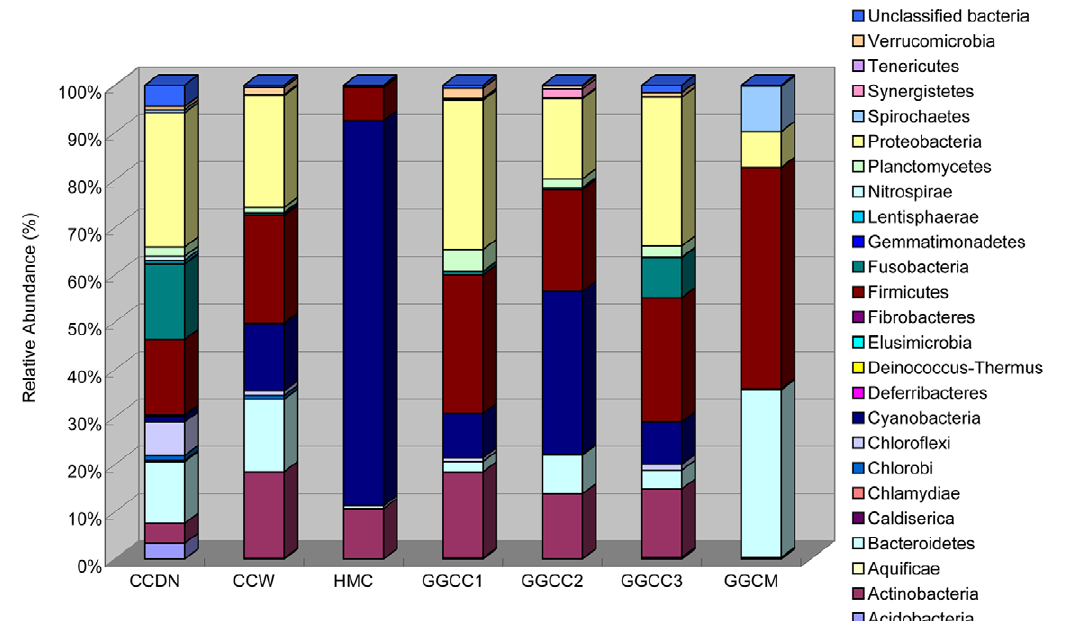
Figure 2. Bacterial composition of the different communities. Relative read abundance of different bacterial phyla within the different communities. Sequences that could not be classified into any known group were assigned as ‘Unclassified bacteria’.